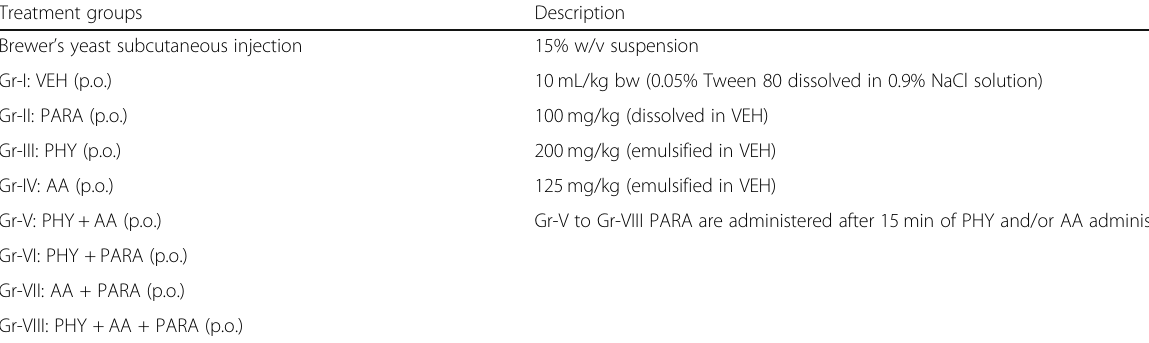
Table 1 Animals fasting overnight are treated with the following substances at 10 mL/kg Treatment groups Description